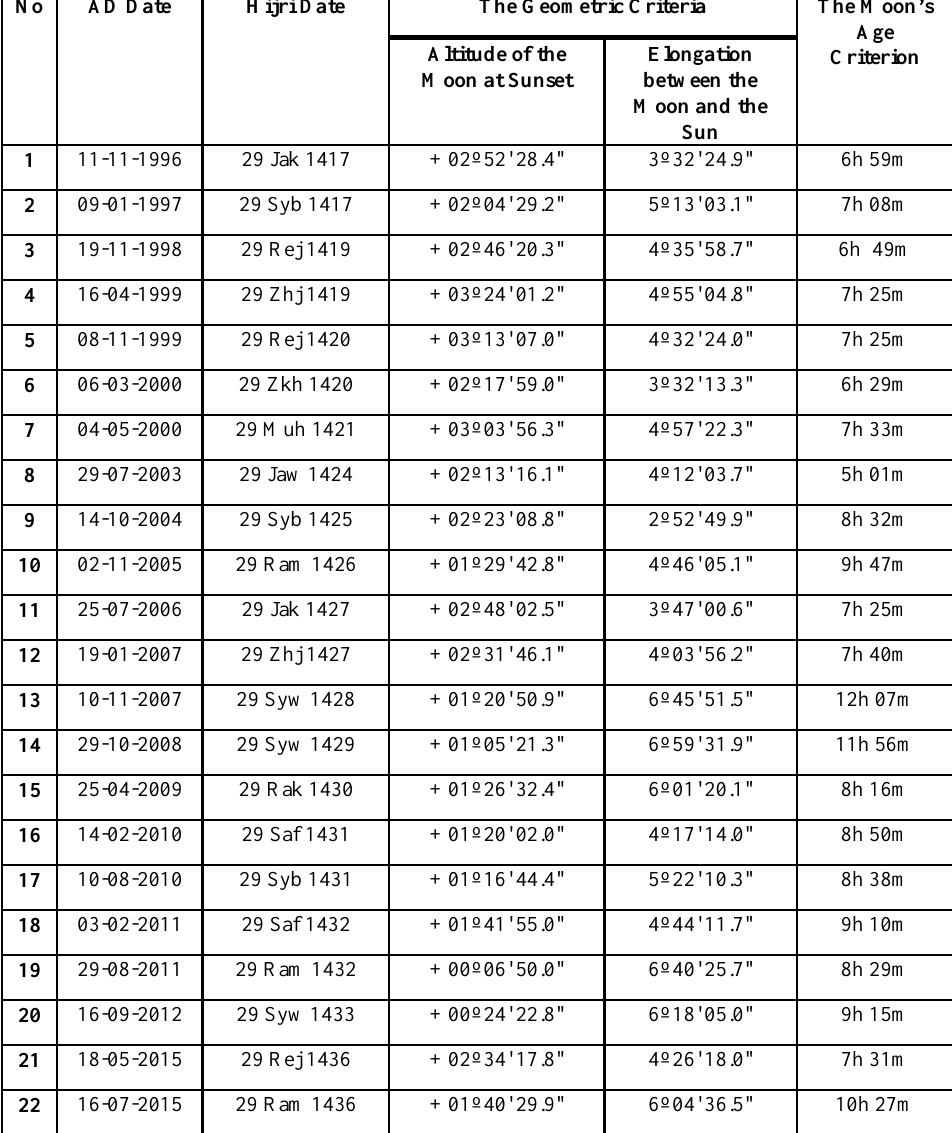
Table 1. The disputes between the geometric criteria and moon’s